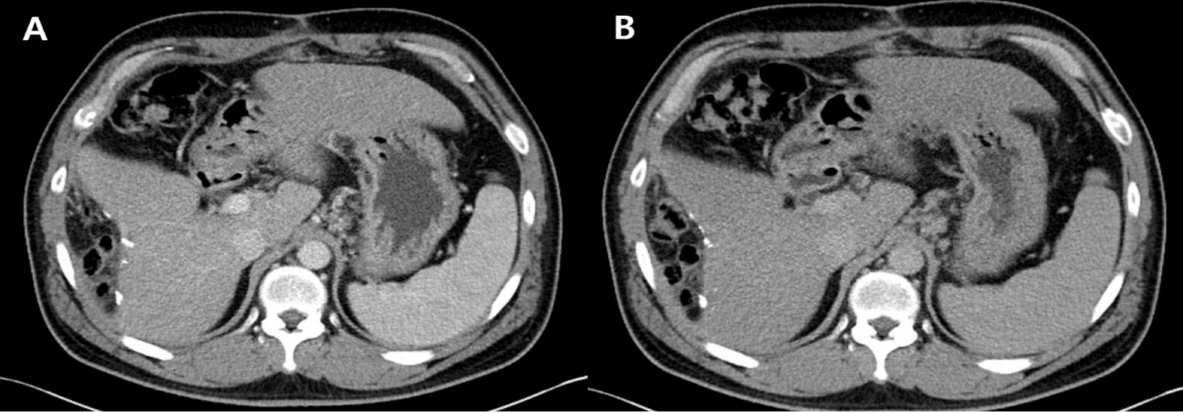
Figure 3. Follow-up dynamic computed tomography scan after 1 year. Multiple surgical clips at the previously resected margin are seen without new lesions: arterial phase ( A ) and delayed phase ( B